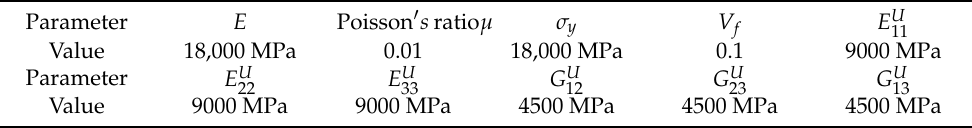
Table 1. The material parameters of the homogenized